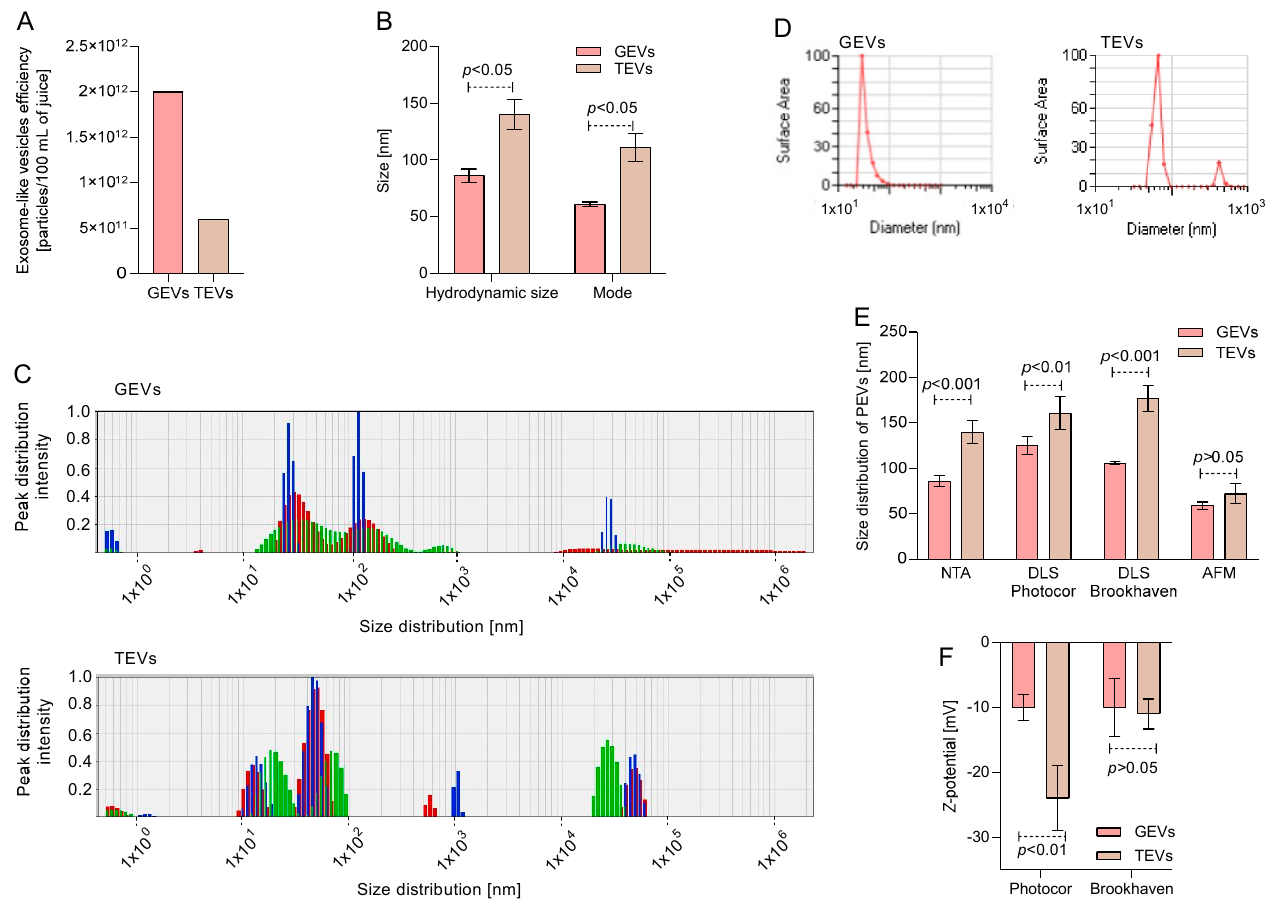
Figure 1. Characterization and particle size of grapefruit exosome vesicles (GEVs) and tomato exosome vesicles (TEVs). Nanoparticle tracking analysis (NTA) of ( A ) concentration as well as ( B ) hydrodynamic size and size mode of GEVs and TEVs. GEVs showed a higher hydrodynamic size and mode distribution than TEVs ( p < 0.05 with unpaired t -student test, n = 3). Representative Dynamic light scattering (DLS) vesicle size distributions of GEVs and TEVs determined by ( C ) Photocor Compact-Z and ( D ) Brookhaven Mod 90 Plus systems. ( E ) Resume of size distribution of GEVs and TEVs by NTA, DLS, and atomic force microscopy (AFM). Overall, TEVs show a higher size distribution than GEVs ( p < 0.05 with unpaired t -student test, n = 3). ( F ) Z-potential of GEVs and TEVs. TEVs show a minor Z-potential than GEVs by Photocor Compact-Z system ( p < 0.01 with unpaired t -student test, n = 3).